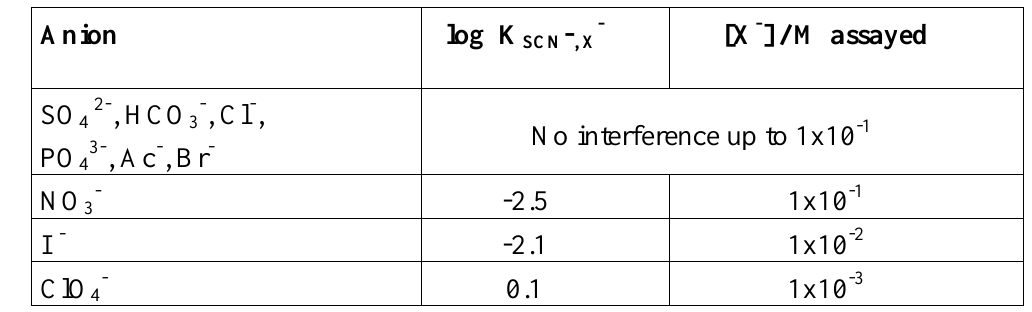
Table 1 . Anion selectivity coefficients.